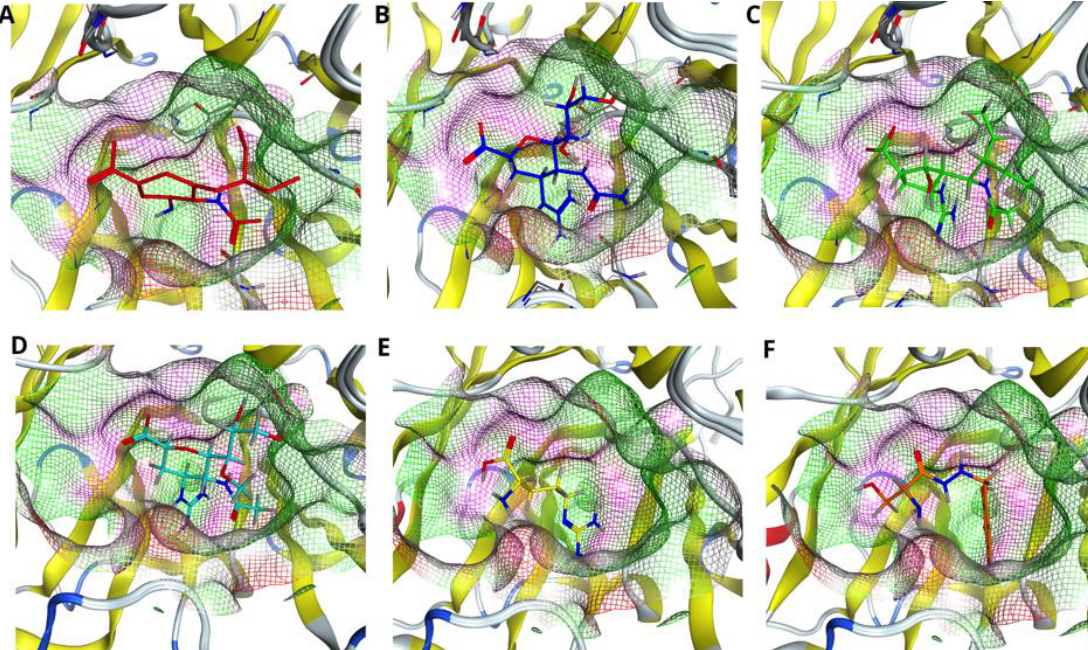
Figure 3. Comparing drug fit to wild type NA binding pocket. Accommodation of the drugs ( A ) Oseltamivir (red), ( B ) Zanamivir (blue), ( C ) Peramivir (green), ( D ) Laninamivir (cyan), ( E ) L-Arginine (yellow) and ( F ) Benserazide hydrochloride (orange) in the pocket of native H7N9 neuraminidase, with reference to the pdb code 4MWQ.